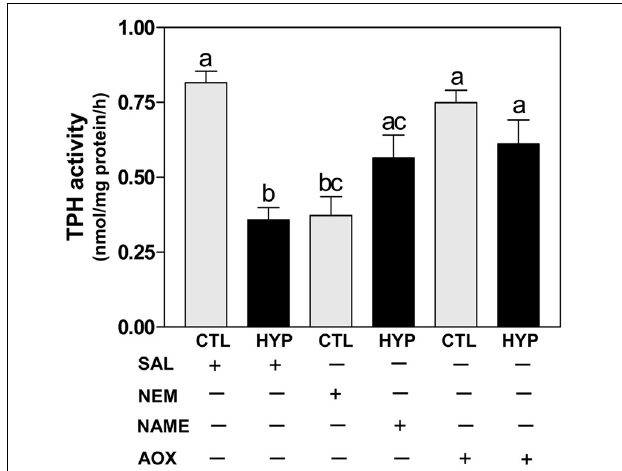
FIGURE 4 | Interactive effects of hypoxia and pharmacological agents that modulate generation of ROS and RNS on TPH activity determined by radioenzymatic assay in croaker hypothalamus. Effects of hypoxia (DO: 1.7mg/L for 4 weeks) exposure and pharmacological treatments with NEM, NAME, and AOX on TPH activity in croaker hypothalamus. Each bar represents mean ± s.e.m. ( N = 6–8, results from both sexes were combined because they were not significantly different). Fisher’s PLSD, are indicated with different letters ( P < 0 . 05). SAL, saline; CTL, control; HYP,